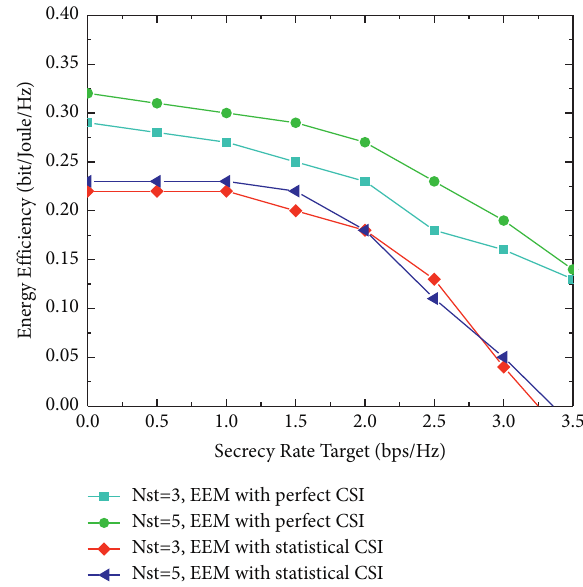
Figure 3: The achieved EE versus the secrecy rates by varying the quantity of the transmitting antennas at the